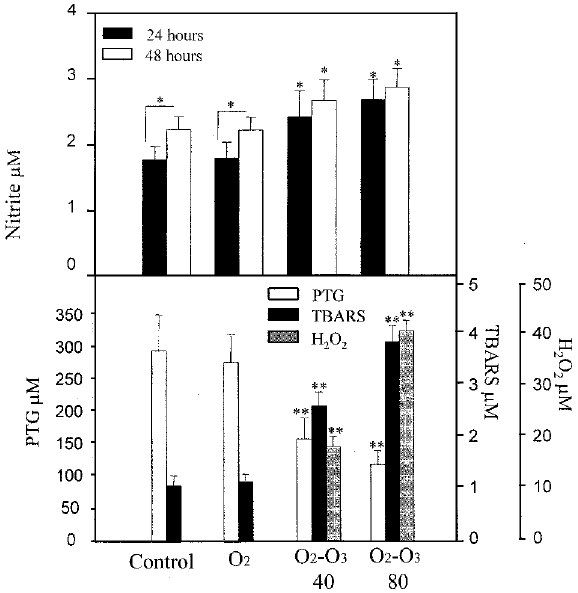
FIG. 1. Effect of different concentrations of ozone on the production of nitrite by HUVECs, 24 and 48h after addition of ozonated human serum (top panel). Effect of either oxygen or ozone on PTG, TBARS and H 2 O 2 levels in the serum before addition to HUVECs. The data are presented as the arithmetic mean ±SD of 6 different experiments.